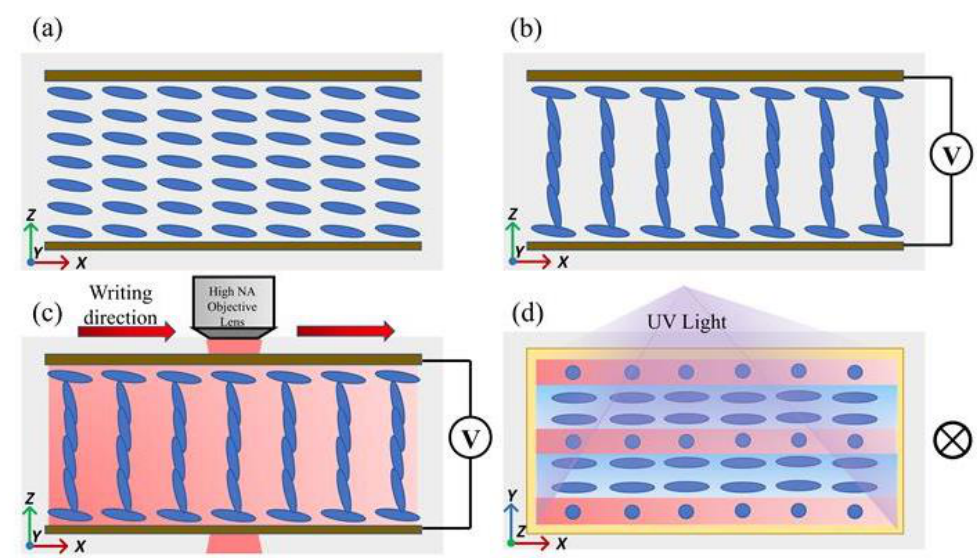
Figure 4. The one-dimensional phase grating fabricated using a combination of laser writing and ultraviolet (UV) illumination. ( a ) The nematic LC was homogeneously aligned such that the director lay in the plane of the glass cell with a pre-tilt at the substrate surfaces of 4 ◦ ; ( b ) The illustration of the LC director switching to a homeotropic alignment with a voltage amplitude of 100 Vrms; ( c ) The laser writer scanned across the LC sample to form thin walls of polymer network along the x -direction that locked-in the homeotropic state; ( d ) After laser fabrication, the voltage was then removed and the sample was exposed to UV illumination to polymerize the remaining LC so as to freeze-in the alignment of the director between the polymer walls after the electric field had been removed. ( a – c ) show a side view of the LC between glass substrates while ( d ) shows a top view after UV polymerization where the pink regions correspond to the polymer walls for which the LC director was homeotropically aligned whereas the blue regions correspond to the bulk regions that have been polymerized using UV illumination and that consist of an LC director that was gradually relaxed from homeotropic alignment. The gratings were polarization dependent, which means that a diffraction pattern was only observed when the polarization of the incident light source was aligned parallel to the rubbing direction.